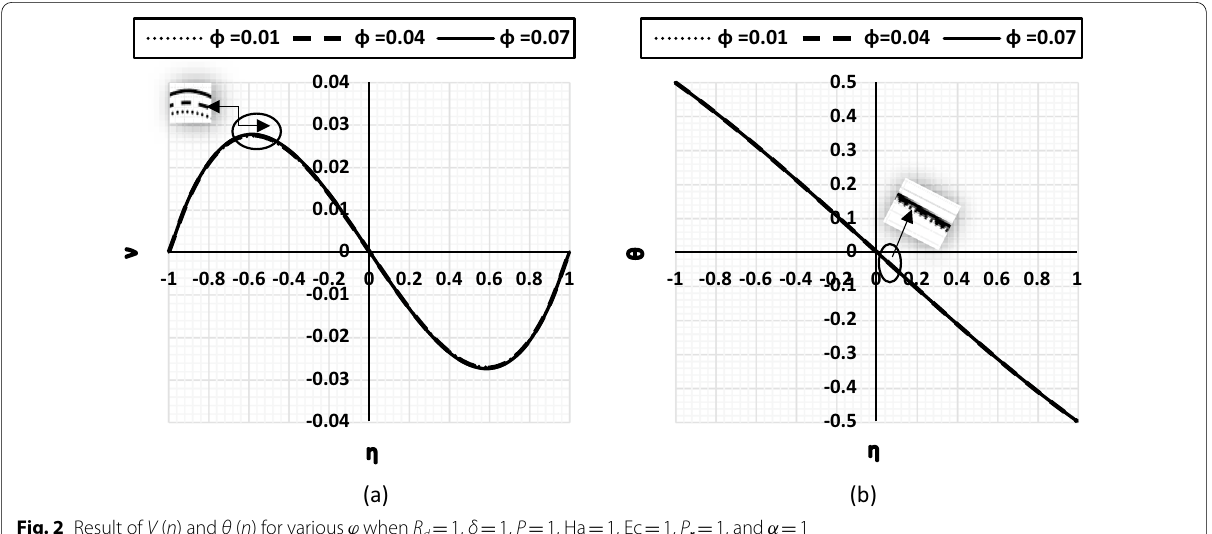
Fig. 2 Result of V ( η ) and θ ( η ) for various ϕ when R d